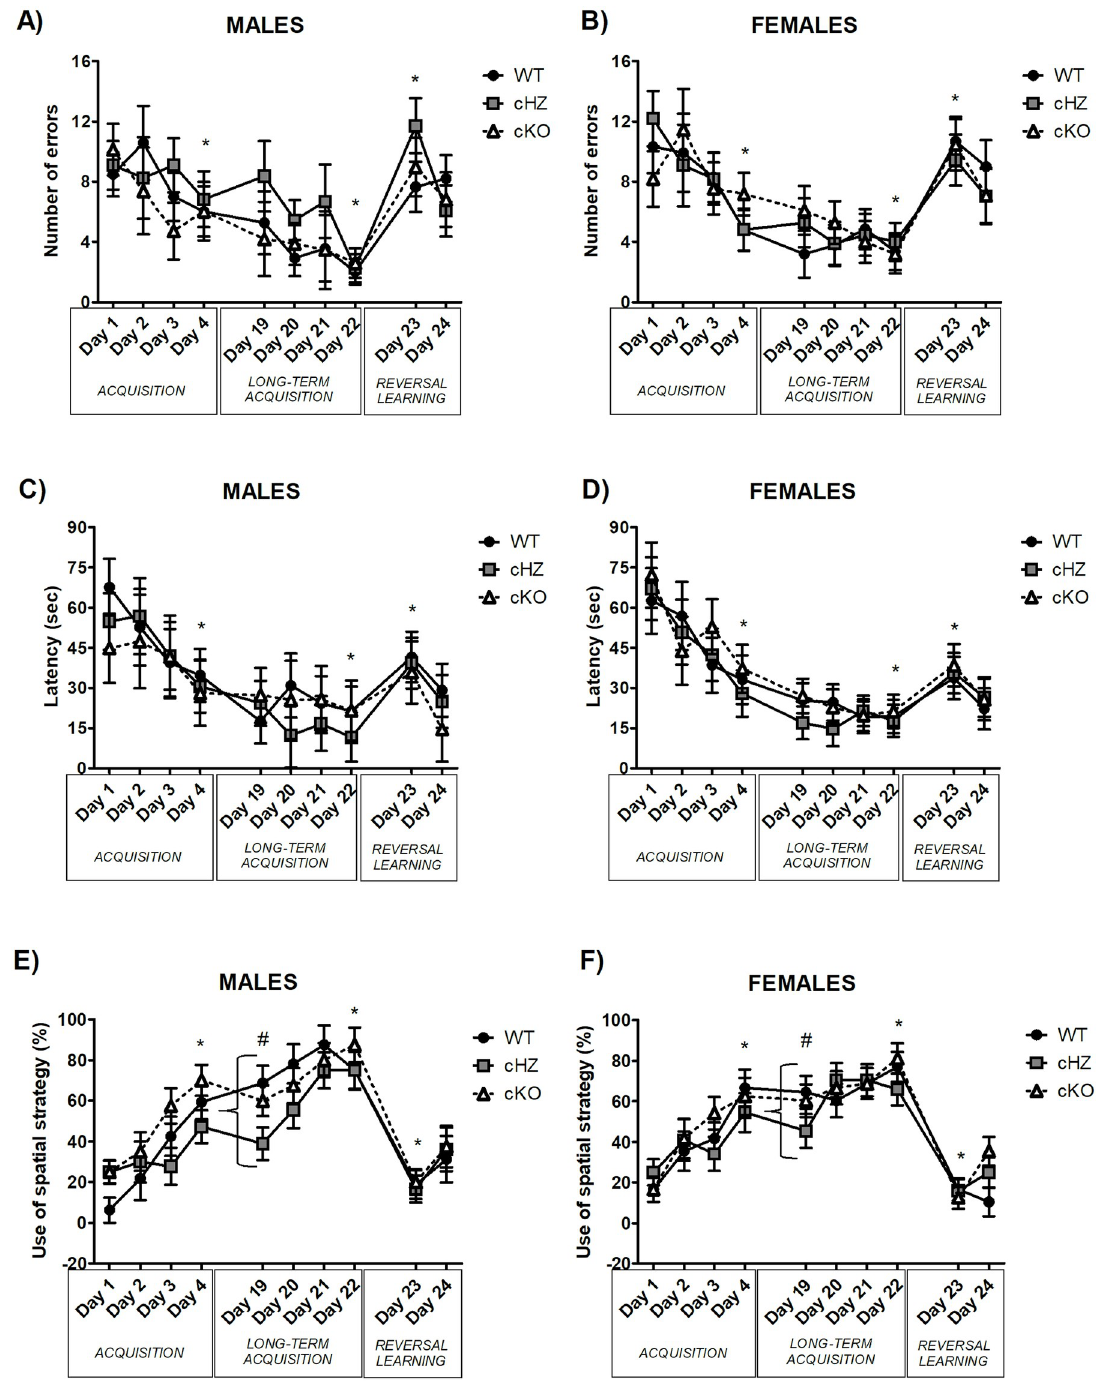
Fig 5. Spatial memory: BM. The lines represent the average per day (4 trials) of the three measured parameters: (1) the number of errors ( A, B ), (2) the latency to find the target hole ( C, D ), and (3) the percentage of use of the spatial strategy ( E, F ) for Males (n = 9) and Females (n = 12). Three groups were compared (Mean and SEM): WT ( Grik4 Cre+/+ , SV2A lox/lox ), cHZ ( Grik4 Cre+/- , SV2A lox/+ ), and cKO ( Grik4 Cre+/- , SV2A lox/lox ). ( � ) indicates that the corresponding marginal mean (main effect of Day ) is significantly different from the previous ones, as yielded by Bonferroni test taken at p < .05. (#) indicates that the corresponding marginal mean (main effect of Genotype ) is significantly different between the groups WT and cHZ, as yielded by a Tukey HSD test taken at p < .05.